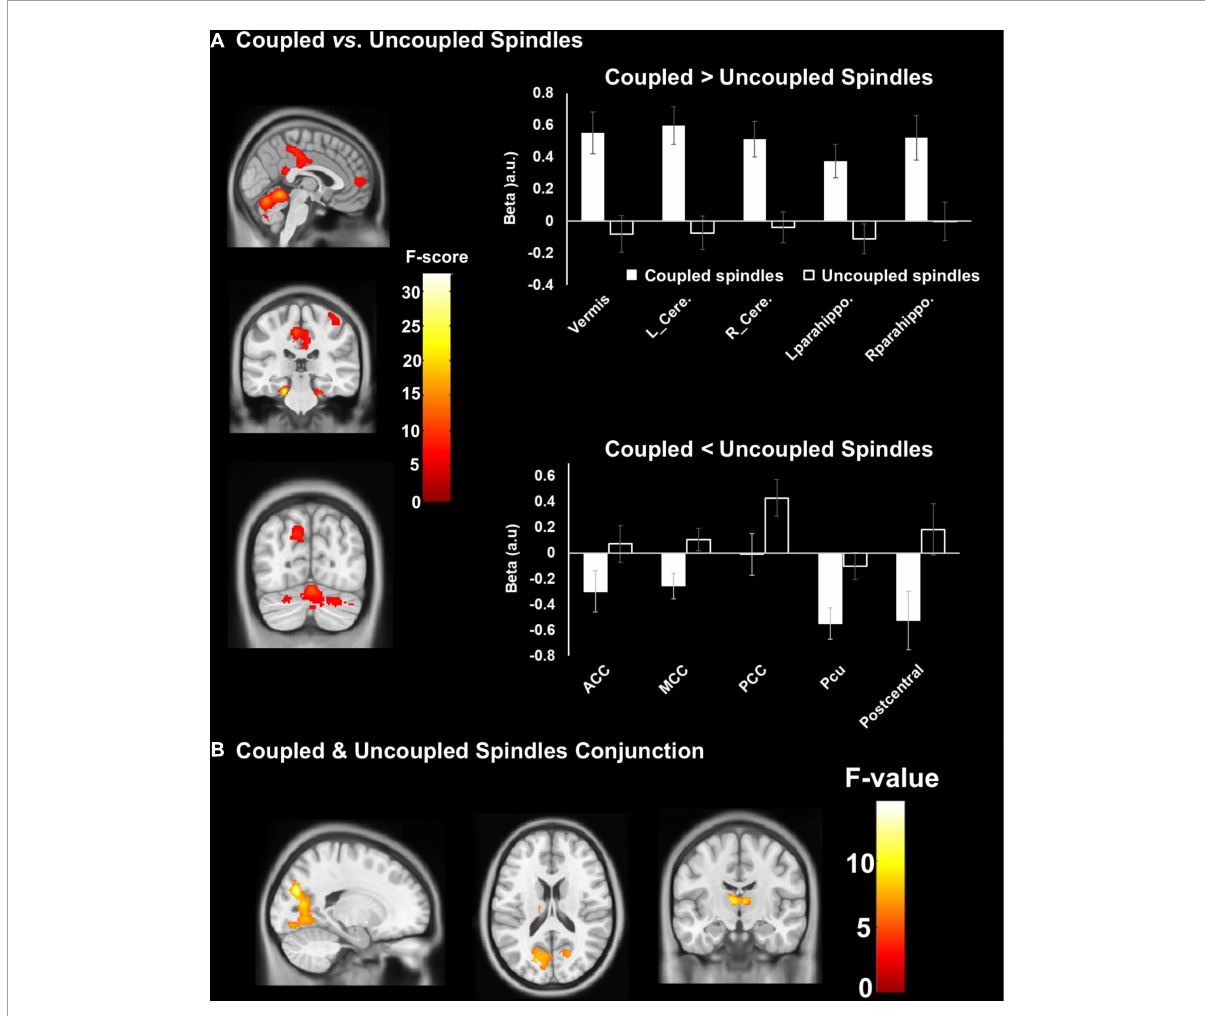
FIGURE4 Differences in cerebral activation between (A) coupled vs. uncoupled spindles, and, (B) conjunction between coupled and uncoupled spindles. Statistical inferences were performed at p < 0.05, FWE was corrected at the cluster level.